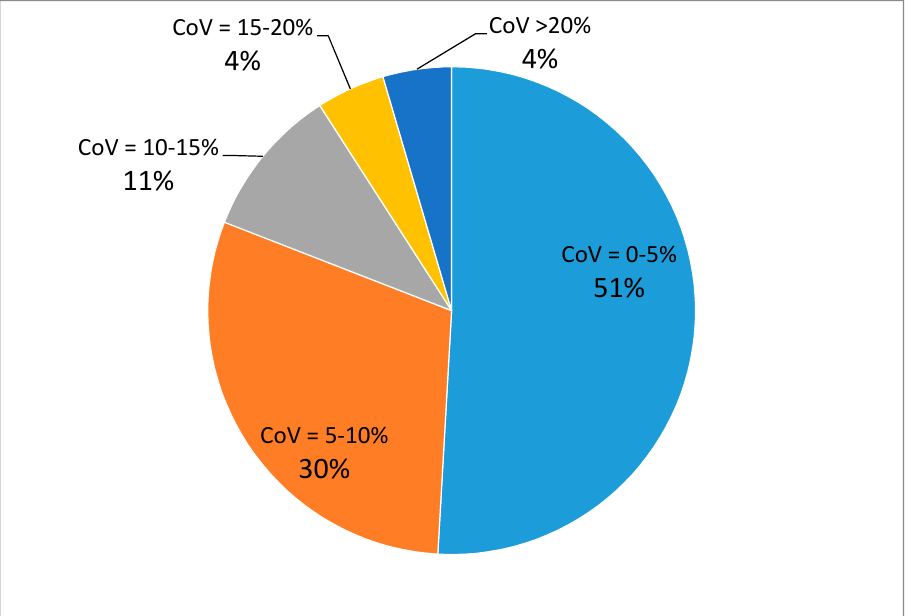
Figure 6. Variability in raw dynamic modulus data.